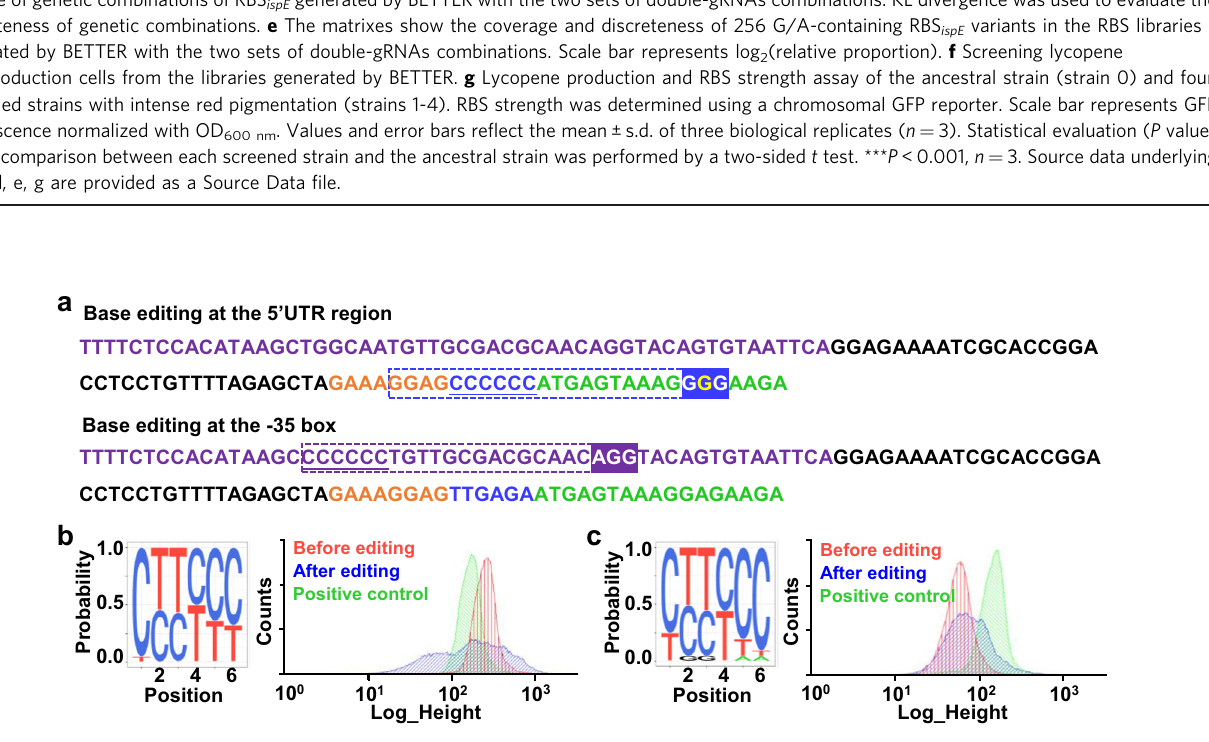
(Fig. 4a). Construction of a G/A-rich library initiated from con- secutive Gs was not selected here to avoid its interference with the upstream RBS. Because there is no available NGG PAM down- stream the target Cs, we introduced a synonymous mutation (GGA to GGG) to generate a GGG PAM. Because the target Cs do not locate at the editing window of Target-AID base editing tool (positions − 20 to − 16, counting the PAM as positions 1 – 3) 13 , we used BE3 12 base editing tool with a larger editing window in C.